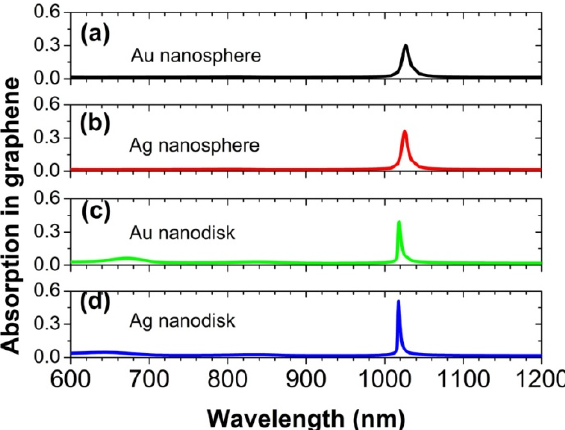
Figure 9. The normal-incidence absorption spectra of the graphene monolayer, for the Au nanosphere to be replaced by the Ag nanosphere, the Au nanodisk, and the Ag nanodisk, respectively. The array periods are px = 400 nm and py = 700 nm. The nanospheres have a diameter of 150 nm. The nanodisks have a diameter of 120 nm and a thickness of 60 nm.